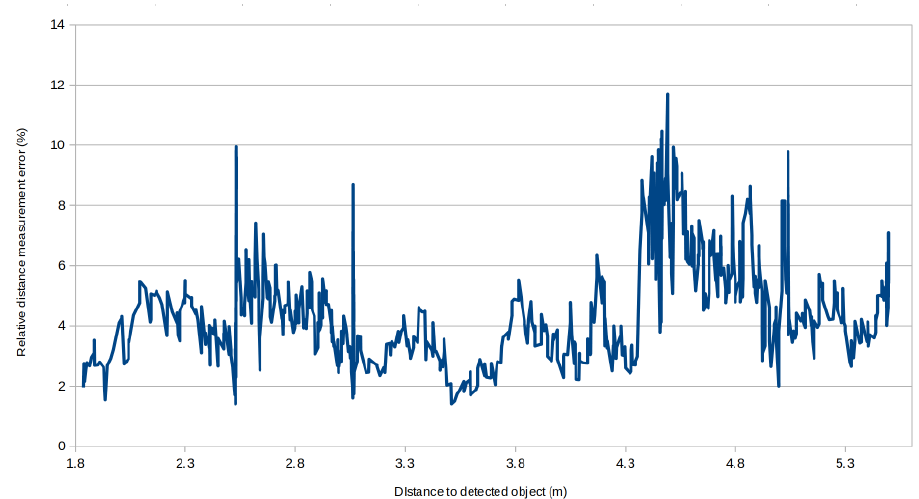
Figure 11. Distribution of the relative distance measurement error, relative to the distance of the detected objects, sliding 5 points